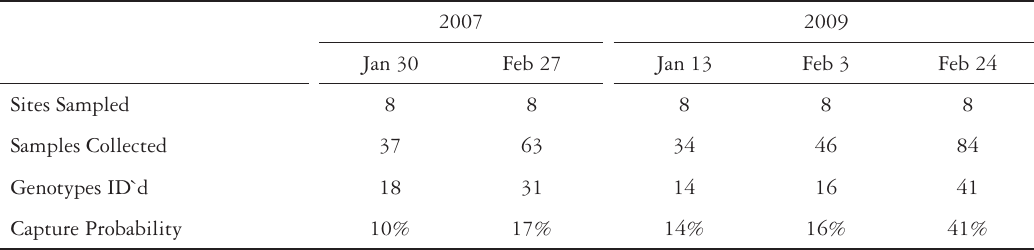
Table 4. Sampling information in the collection of woodland caribou faecal pellet samples from the Slate Islands Provincial Park in 2007 and